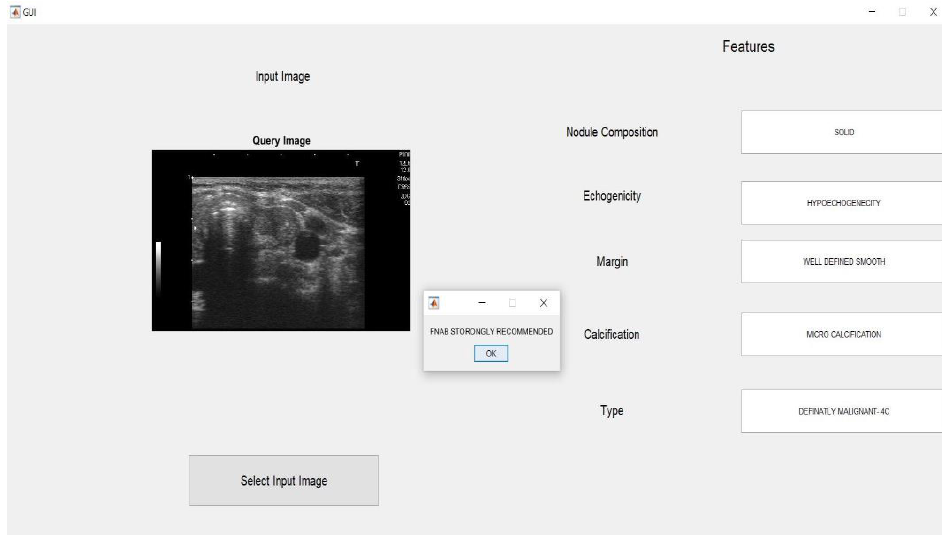
Figure 14. GUI for malignant nodule.